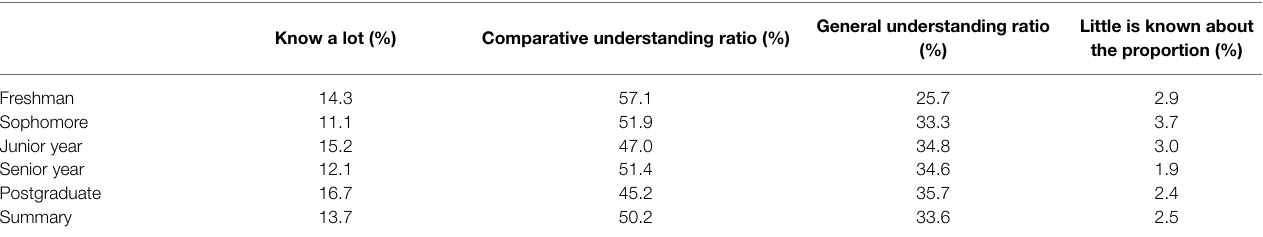
TABLE 3 | Statistical table on the level of concern for social justice.